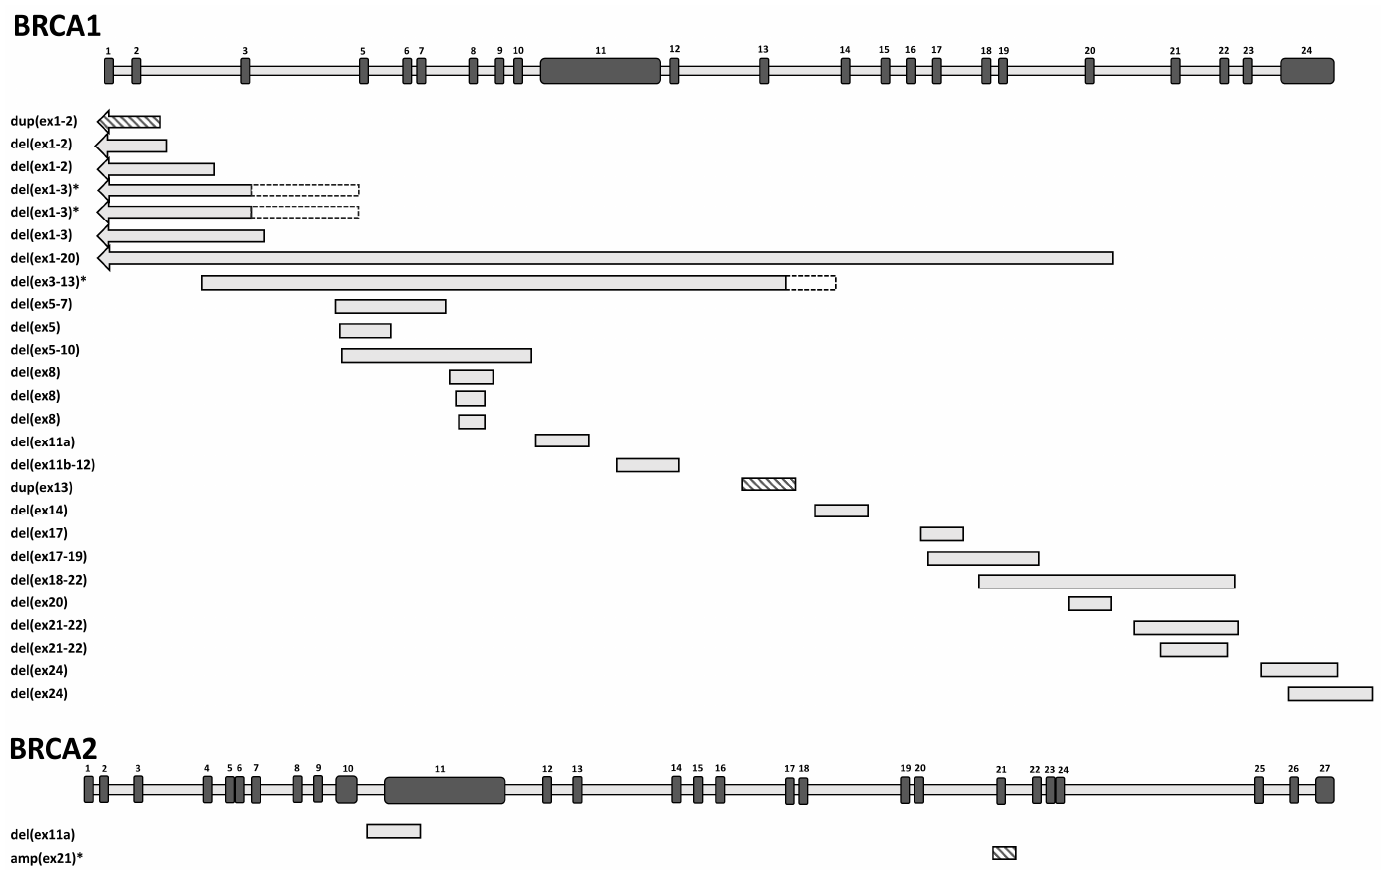
Figure 3. Position of the detected large genomic rearrangements (LGRs) along the BRCA1 and BRCA2 genes. Genes are drawn in sense orientation without promoter region. The length of exons (black bars) and introns (grey bars) are not exactly to scale. Exon numberings are given above them. Each di ff erent LGR variant is represented once. Deletions are depicted with grey boxes, duplications are depicted with striped boxes. Respective LGR running names indicating their exon a ff ections are listed on the left. Arrows indicate that the rearrangements outreached the gene towards upstream direction. LGRs with uncertain breakpoints are labeled with an asterisk. Additionally, where breakpoint uncertainty is larger than 1 kb, dashed outlines of the bars indicate the possible breakpoint